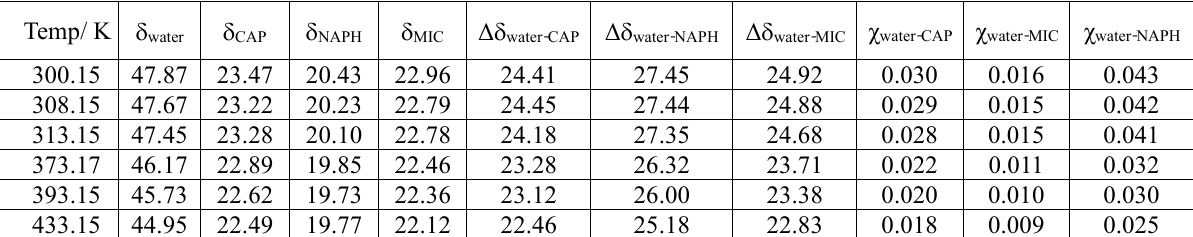
Table 4. Hildebrand solubility and F-H interaction parameters of SVOCs in water Temp/ K 